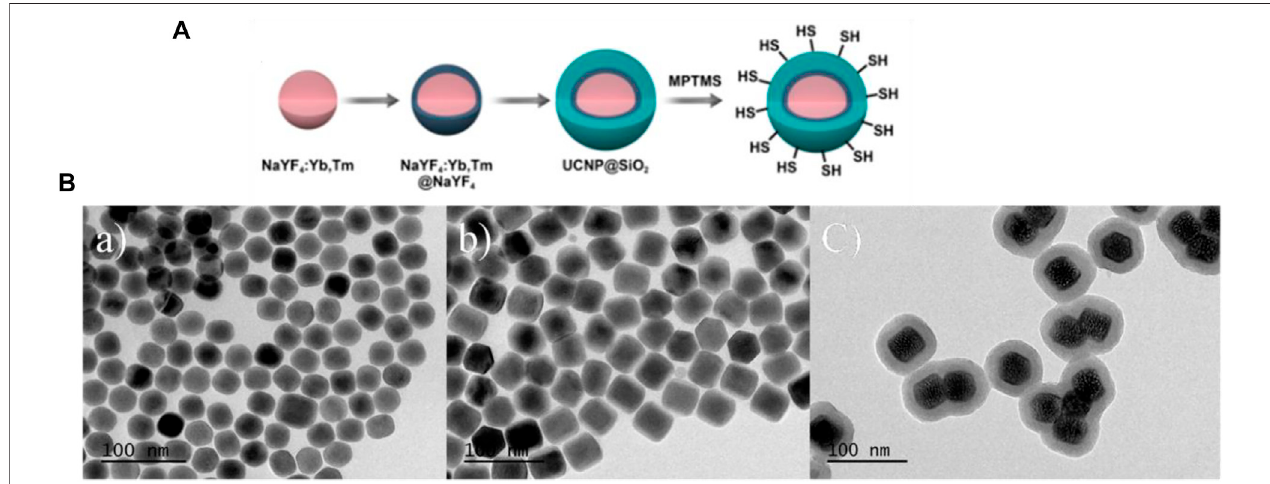
FIGURE 1 | (A) Synthesis procedures of UCNPs, (B) TEM images of core (a) , core – shell (b) nanoparticles for NaYF4:Tm/Yb and NaYF4:Tm/Yb@NaYF4 UCNPs, respectively. UCNPs@SiO 2 NPs (c) .